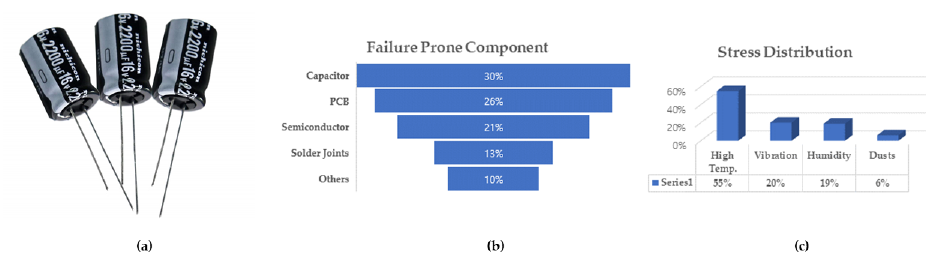
Figure 1. A representation of the fault prone components in power electronic systems, ( a ) A typical 16 V 1000 uf aluminum electrolytic capacitor ( b ) Root cause breakdown and ( c ) Common causes of failure in power